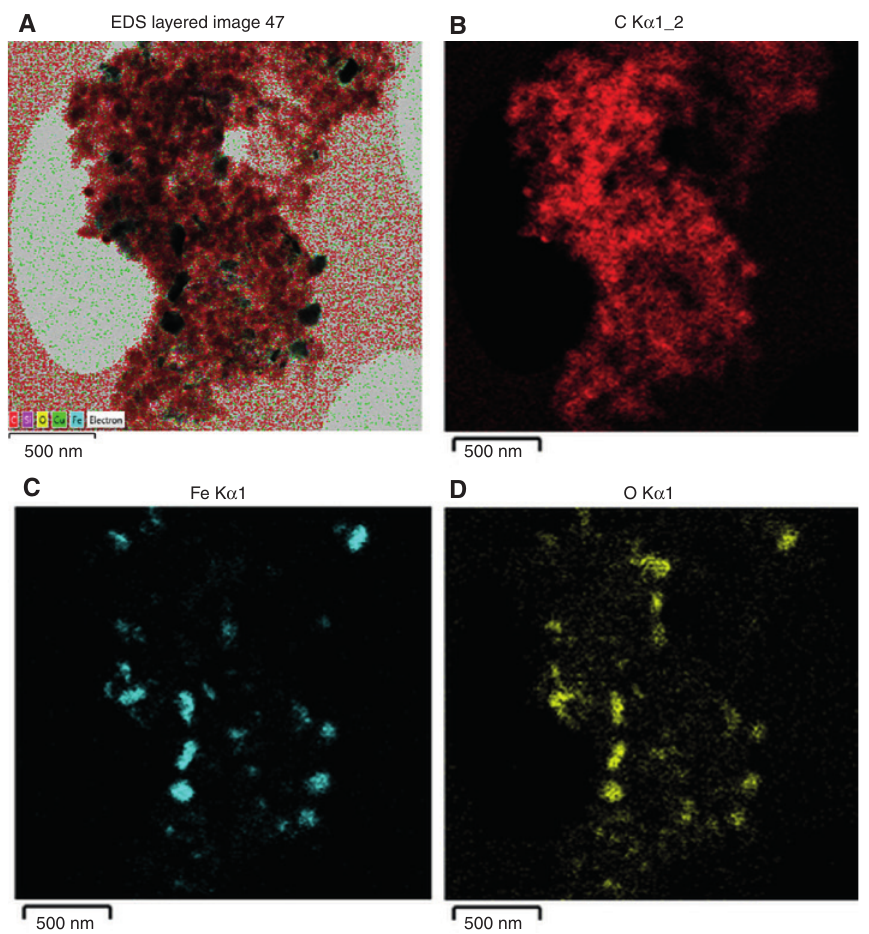
Figure 6: HAADF image (A) and compositional maps (B, C, D) of the carbon black-magnetite hybrid